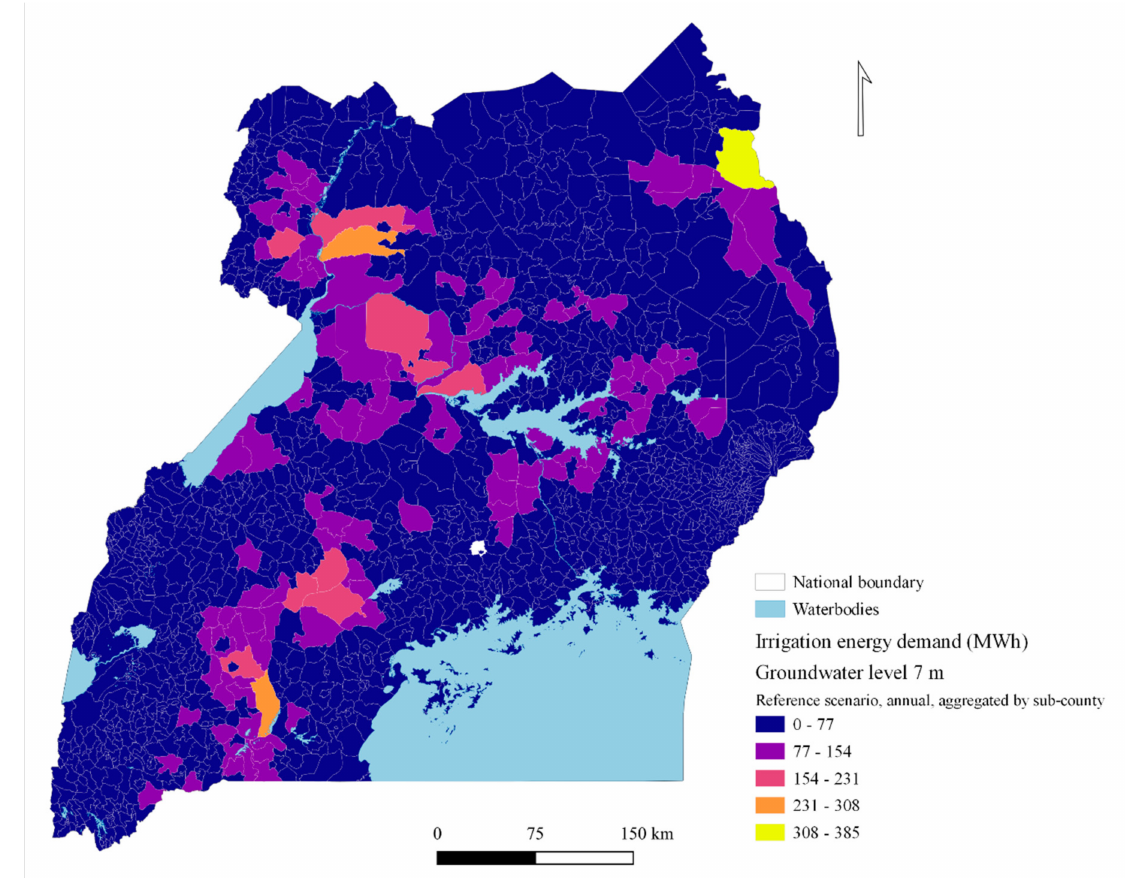
Figure 9. Aggregated annual energy demand (MWh) for irrigation water pumping per sub-county, reference scenario. The highest annual energy demand is linked to the area of the sub-county and the energy intensity per hectare.